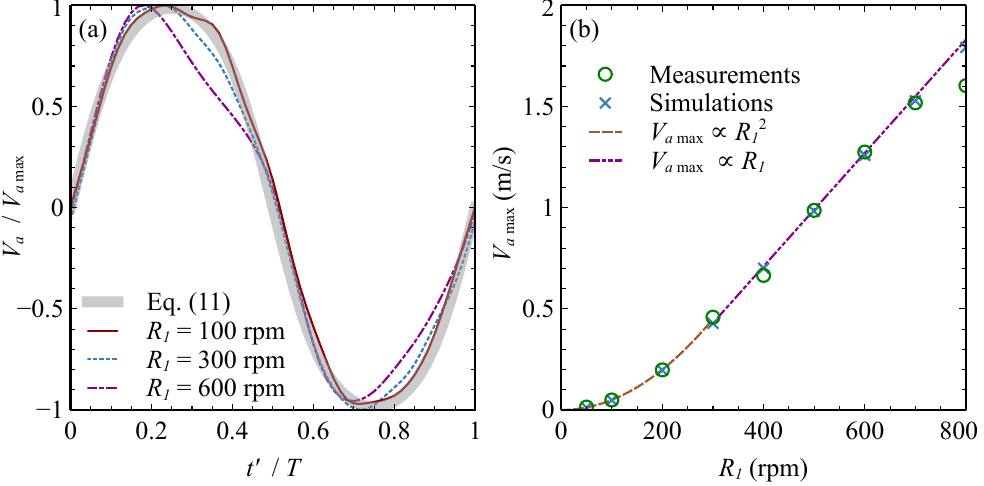
Figure 3. ( a ) Measured time series of flow velocity ( V a ) for T = 6 s and R 1 = 100, 300, and 600 rpm with U-tube mode. ( b ) The maximum velocity V a max against R 1 from the experiments and simulations.